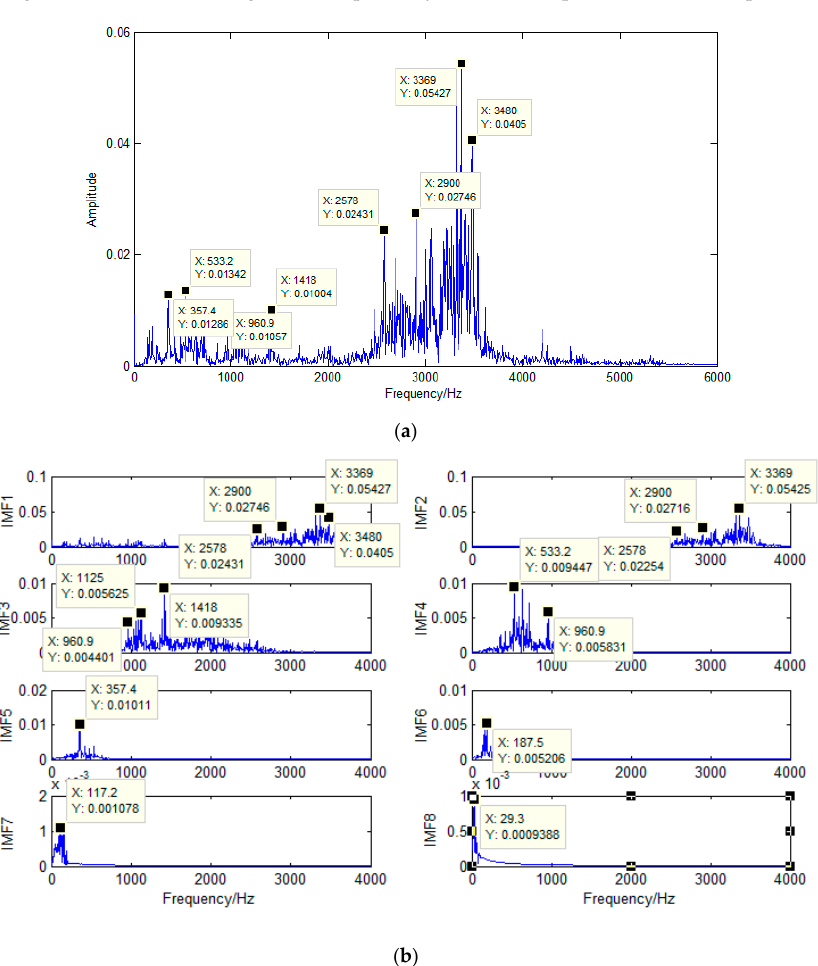
Figure 9. Spectrogram of a BF signal and its IMFss. ( a ) Spectrogram of a BF signal sample; ( b ) Spectrogram of the eight-order IMFs.